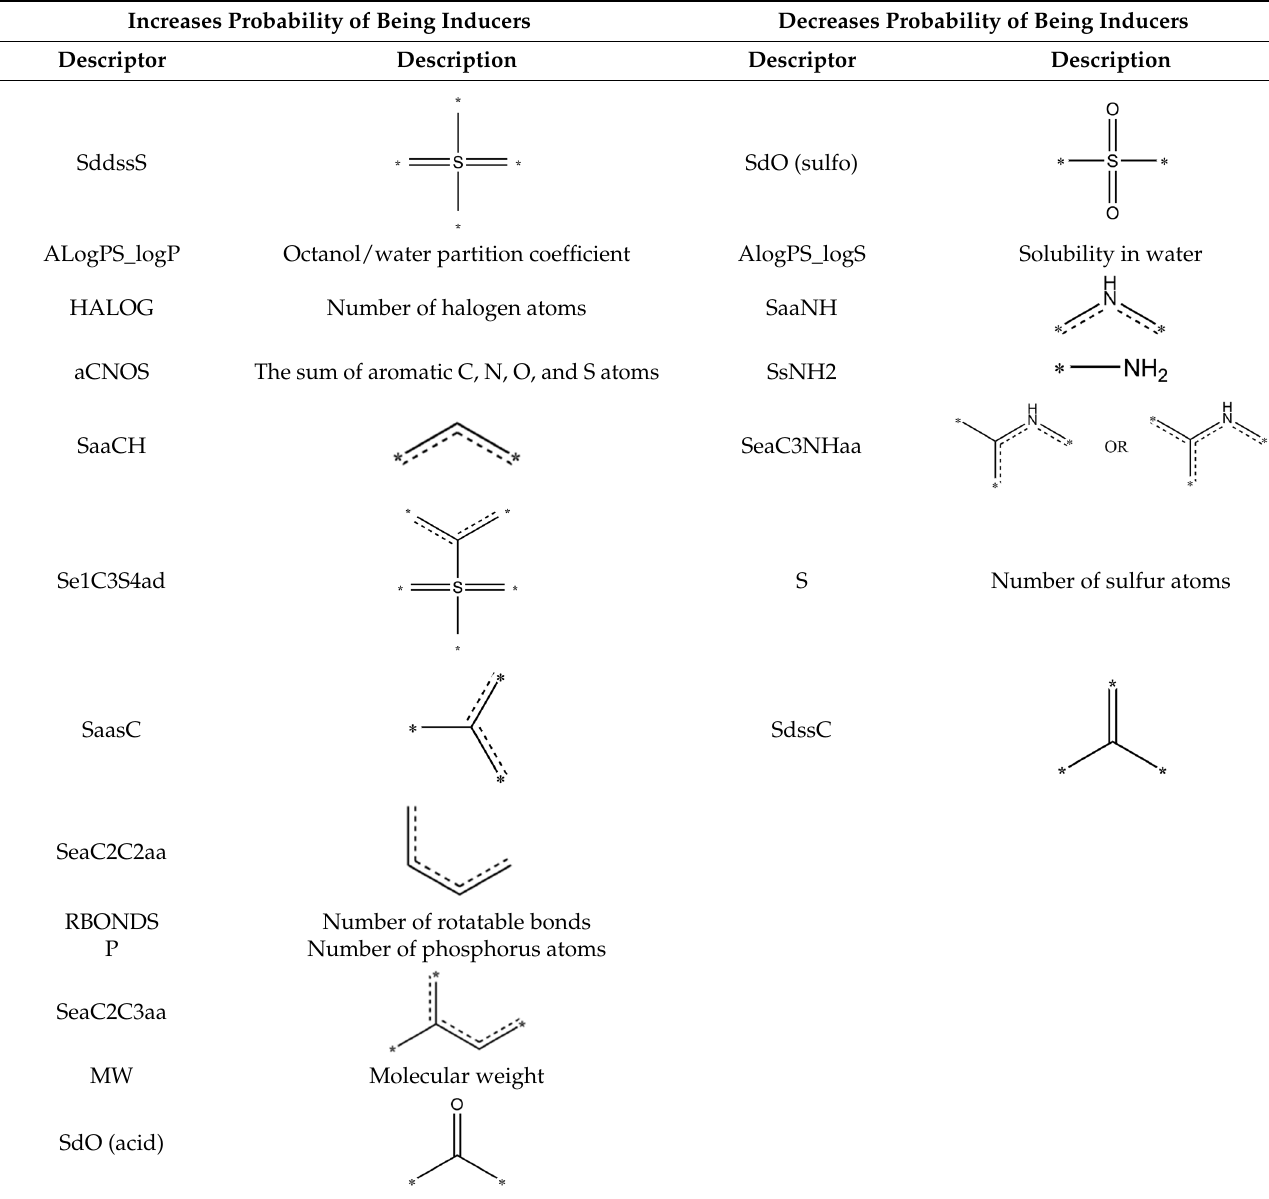
Increases Probability of Being Table 2. The most influential descriptors to classify ligands as inducers. a. Table 2. The most influential descriptors to classify ligands as inducers a .